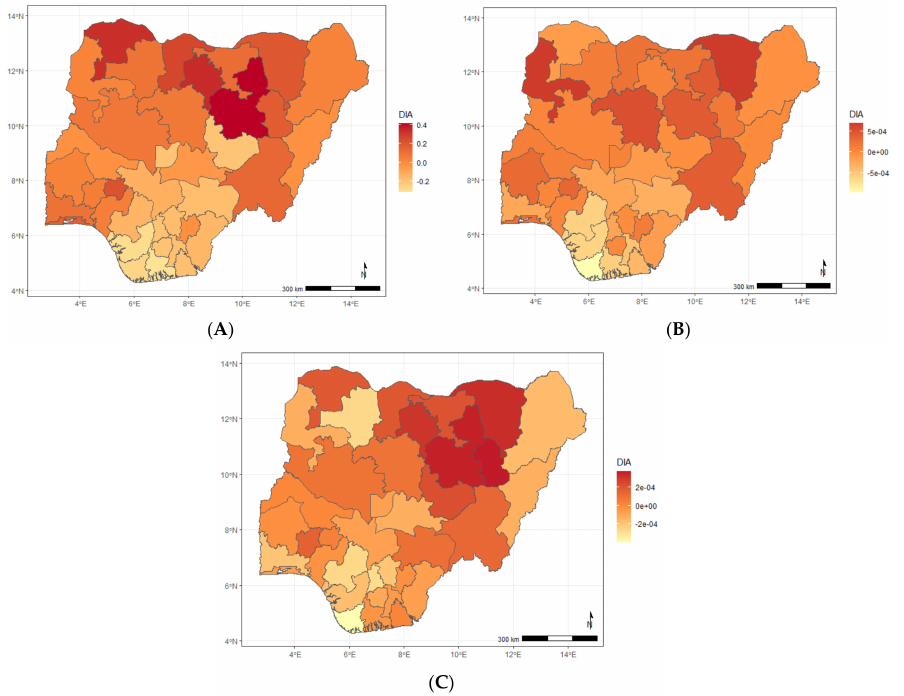
Figure A2. Maps showing posterior estimates of diarrhoea-specific spatial effect by year of NDHS implementation; ( A ) 2008, ( B ) 2013, ( C )